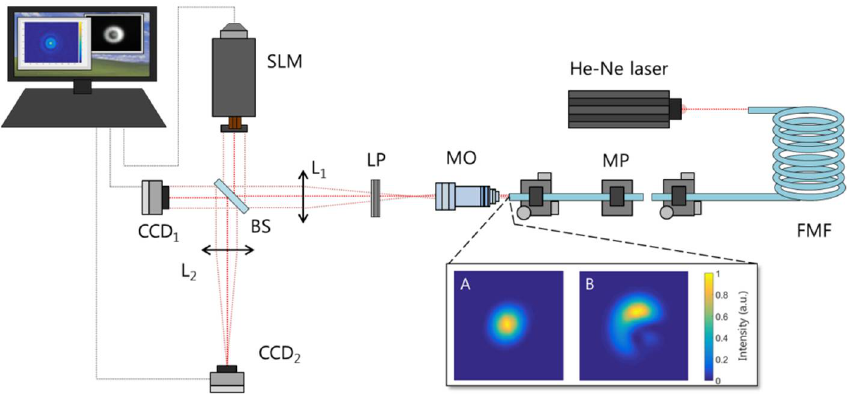
Figure 2. Scheme of the modal analysis setup. FMF: few mode fiber, MP: micro-positioners, MO: microscope objective, L 1 and L 2 : lenses, LP: linear polarizer, BS: beam splitter, CCD: cameras, SLM: spatial light modulator; A and B are the measured transversal intensity distributions in order to align the setup and test the proposed techniques, respectively.